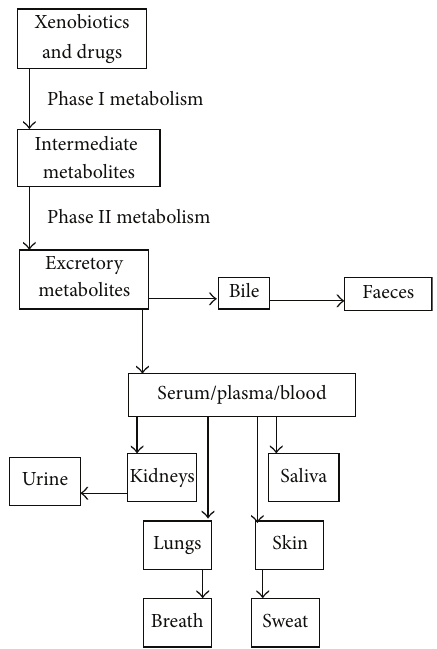
Figure 1: Routes of excretion of various products after liver metabo-